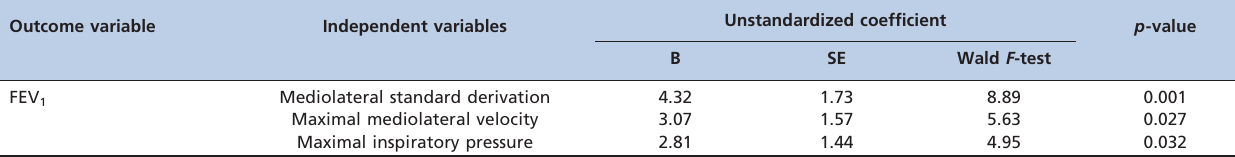
Table 4 - Multifactorial variance analysis of the relationship between the pulmonary function, functional capacity, posture, balance, and clinical data of the studied subjects. Only statistically significant associations are presented. Outcome variable Independent